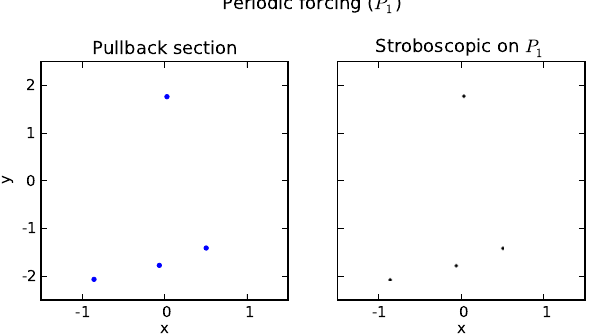
Fig. 5. Pullback (at t 0 = 0) and stroboscopic sections ( t = 0 + nP 1 ) obtained with the van der Pol oscillator, with parameters α = 30, β = 0 . 7, τ = 36 forced by F(t) = γ sin ( 2 π/P 1 t + φ P 1 ) , P 1 = 23 . 7ka, φ P 1 = 32 . 01 ◦ and γ = 0 . 6. The two plots indicate a case of 4 : 1 synchronisation, and they are identical because the forcing is periodic.